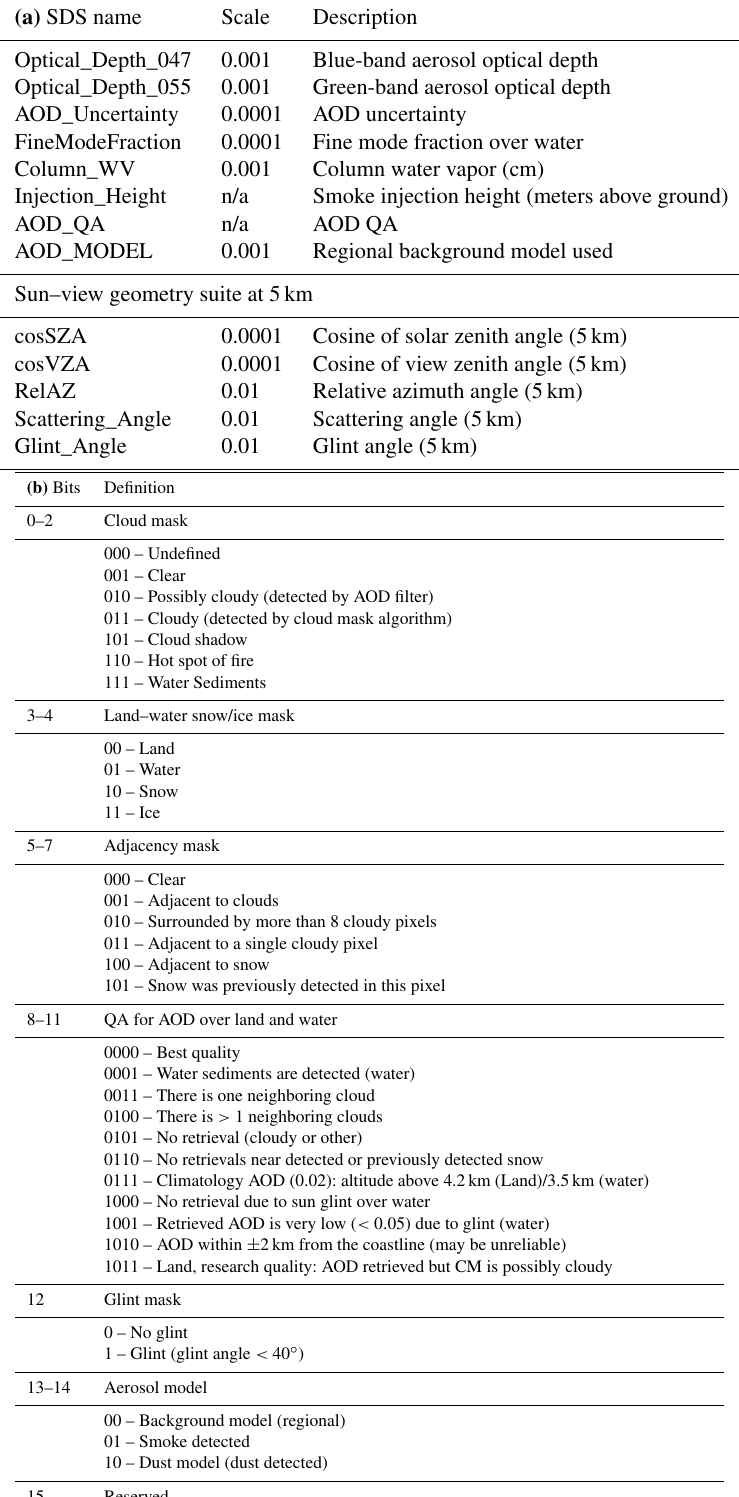
Table 2. (a) Reported parameters in the atmospheric properties file (MCD19A2). (b) AOD QA definition for MCD19A2 (16bit unsigned integer). N/a is not